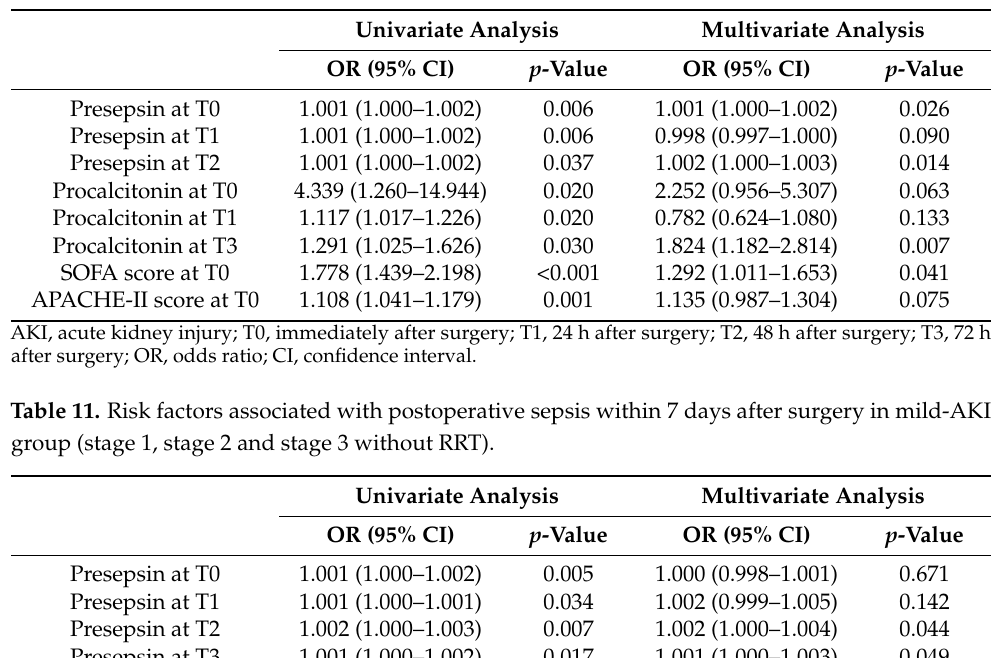
Table 10. Risk factors associated with postoperative sepsis within 7 days after surgery in non- AKI group.